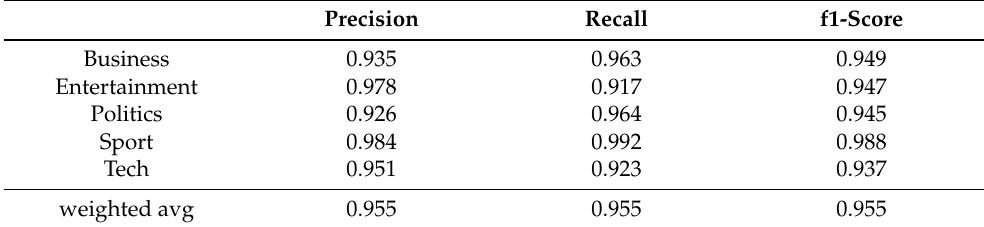
Table 9. Classification statistics for predicting preassigned classes by detected dominant topics ( p = 100, γ = 1.0); to be compared with Table 5. Note that Table 12 contains a combined view of f1-scores for all classification statistics for easier